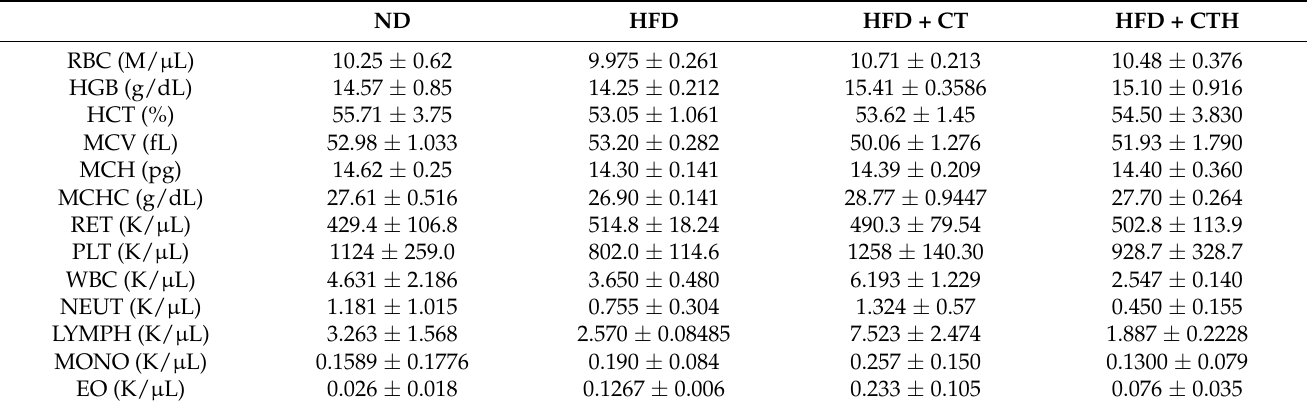
Table 2. Complete blood